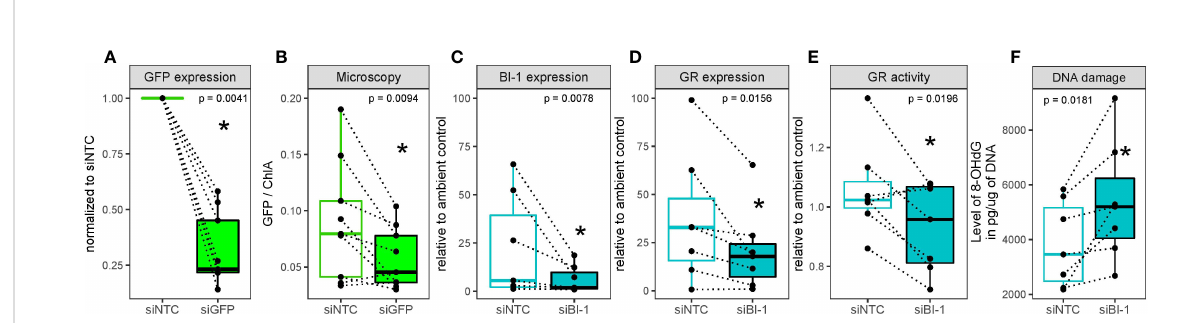
FIGURE 4 BI-1 overexpression in heat-stressed preconditioned corals improves DNA damage protection via regulation of glutathione reductase activity. (A) Expression of GFP in corals treated with siGPF, normalized to siNTC, n = 9 (B) Confocal microscopy analysis of GFP-derived signal normalized to symbiont-derived signal in the same corals, n = 9 (C, D) Expression of BI-1 and glutathione reductase genes, respectively, in heat-stressed PC corals is ef fi ciently reduced after siRNA-mediated gene knockdown (siBI-1). siNTC represents PC corals treated with a negative control siRNA. Data are normalized to untreated corals at ambient temperature, n=7 (E) The activity of glutathione reductase decreases upon siBI-1 knockdown in PC corals. Data are normalized to untreated corals at ambient temperature, n = 7. (F) The level of oxidized guanine in coral DNA during heat stress increases after siBI-1 knockdown in PC corals (n = 7). Dotted lines connect paired samples from the same colony. The boxplots show median of the data, fi rst and third quartile and respective datapoints. * represents p value <